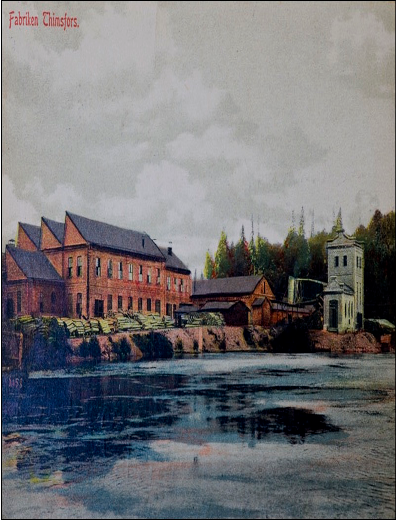
Figure 1. The paper mill in Timsfors.